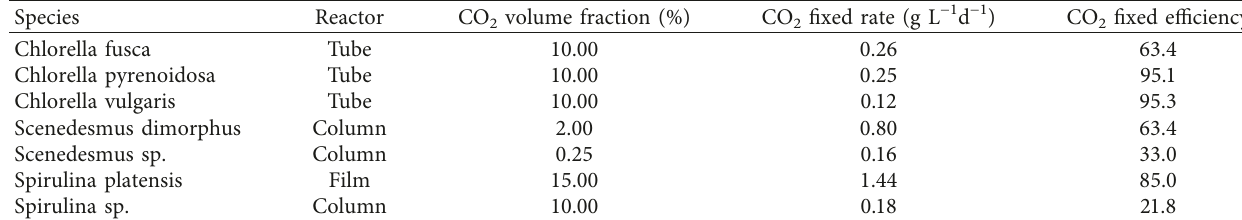
Table 1: Carbon sequestration efficiency of microalgae in closed reactors.